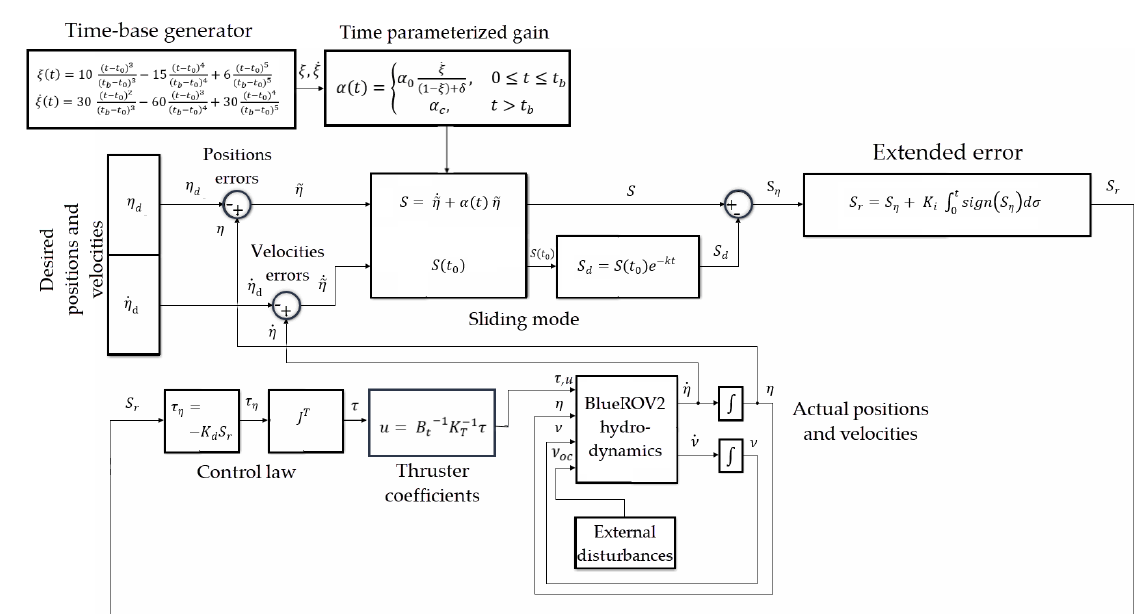
Figure 3. Model-free high-order Sliding Mode Control (SMC) with Time Base Generator (TBG) scheme.